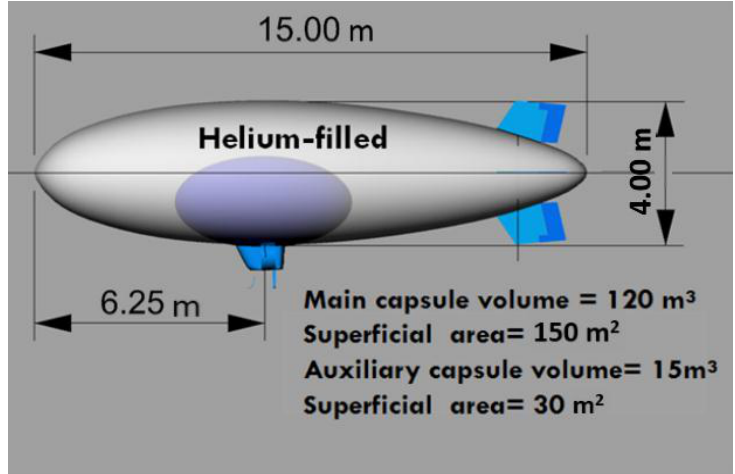
Figure 2. Airship capsule diagram.